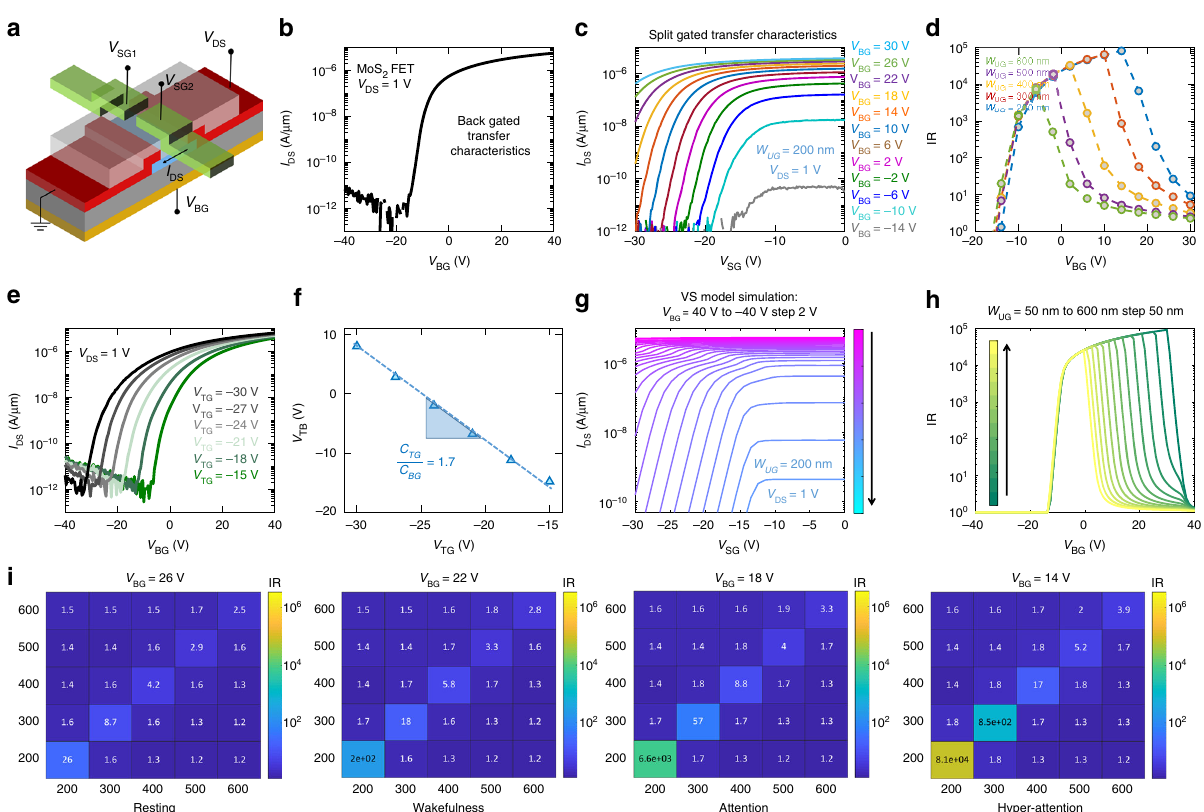
Fig. 5 Neuroplasticity in biomimetic audiomorphic device. a Schematic of the biomimetic device with global back-gate using 285 nm SiO 2 as the dielectric and heavily doped Si as the back-gate electrode. b Back-gate transfer characteristics for V DS = 1 V. The back-gate threshold voltage was V TB = − 12 V. c Transfer characteristics of the biomimetic device when the split-gate pair with 200 nm spacing are concurrently swept from 0 V to − 30 V under different back-gate ( V BG ) biases. d Inhibition ratio (IR) as a function of V BG for different split-gate spacing extracted from the corresponding transfer characteristics shows a non-monotonic trend. For, V BG » V TB , the device is in the deep ON state and hence the current through the ungated region remains high for V SG = − 30 V resulting in low IR. As V V = 0 V only reduces linearly but since it becomes relatively easier BG approaches V TB , the current through the device for SG for the split-gates to switch the ungated channel region from ON state to subthreshold for V SG = − 30 V reducing the device current exponentially and resulting in an increased IR. Once V BG goes below V TB , the entire device enters subthreshold operation. Now the current through the device for V SG = 0 V ( V TG ) at V DS = 1 V. f Iso-current V TB as a function of V TG shows the strength of coupling between two gated in a dual gated geometry. g Simulated transfer